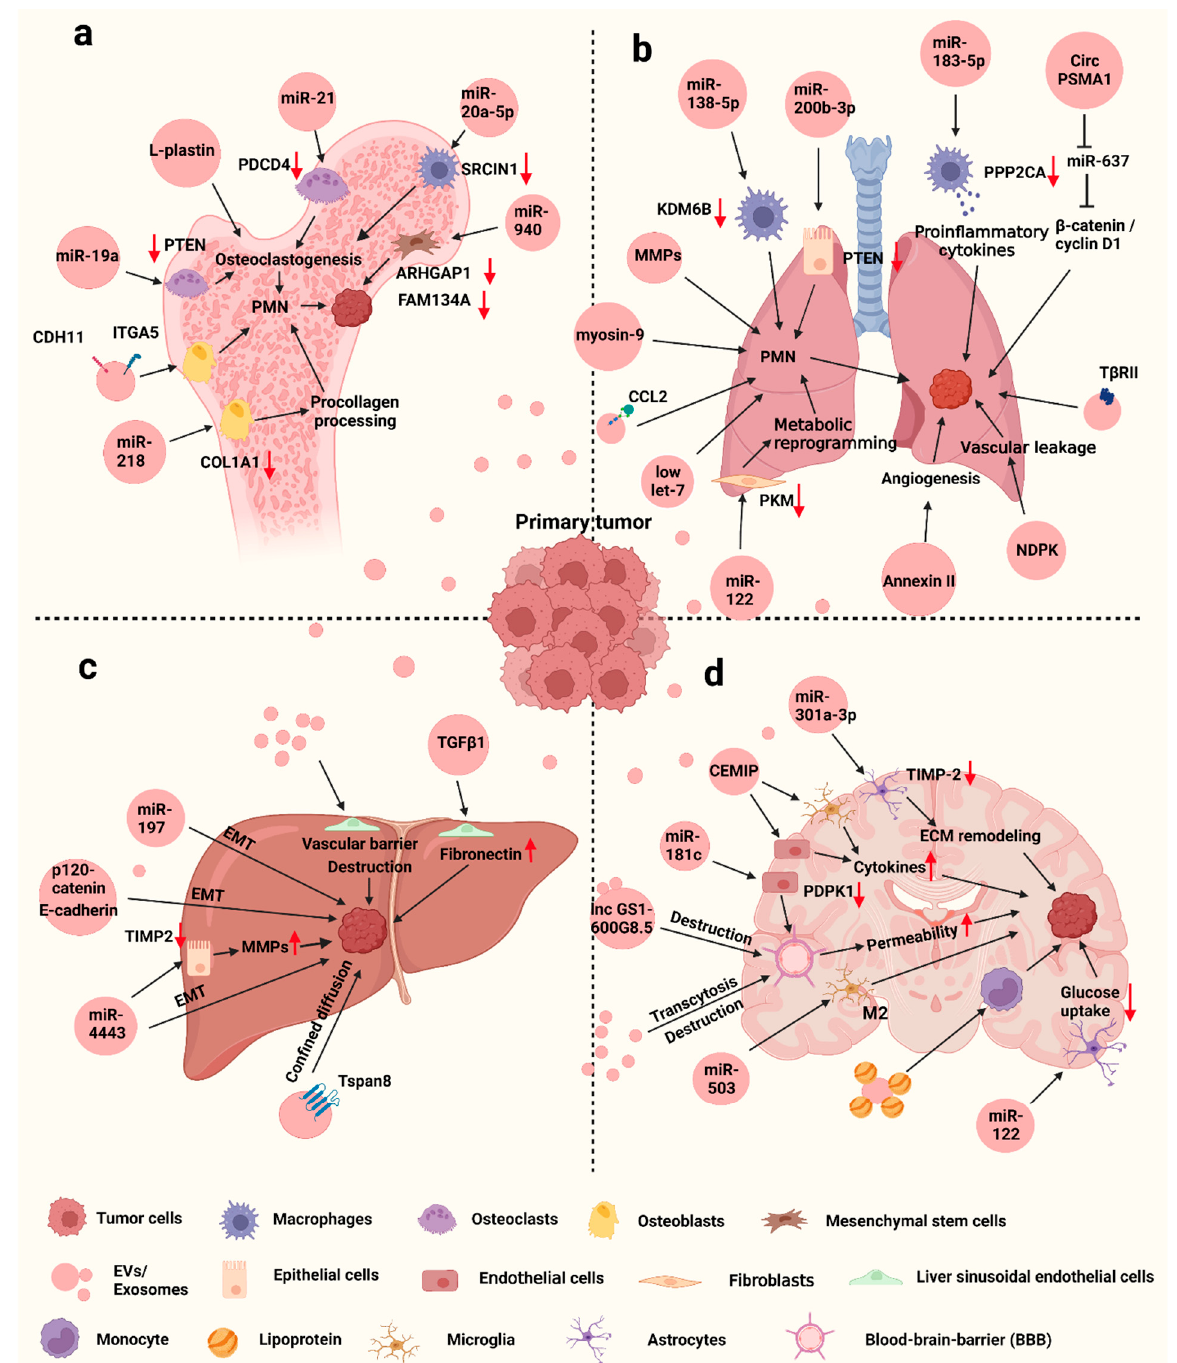
Figure 2. Exosomes mediate breast cancer metastasis to bone ( a ), lung ( b ), liver ( c ) and brain ( d ). Figure is created by